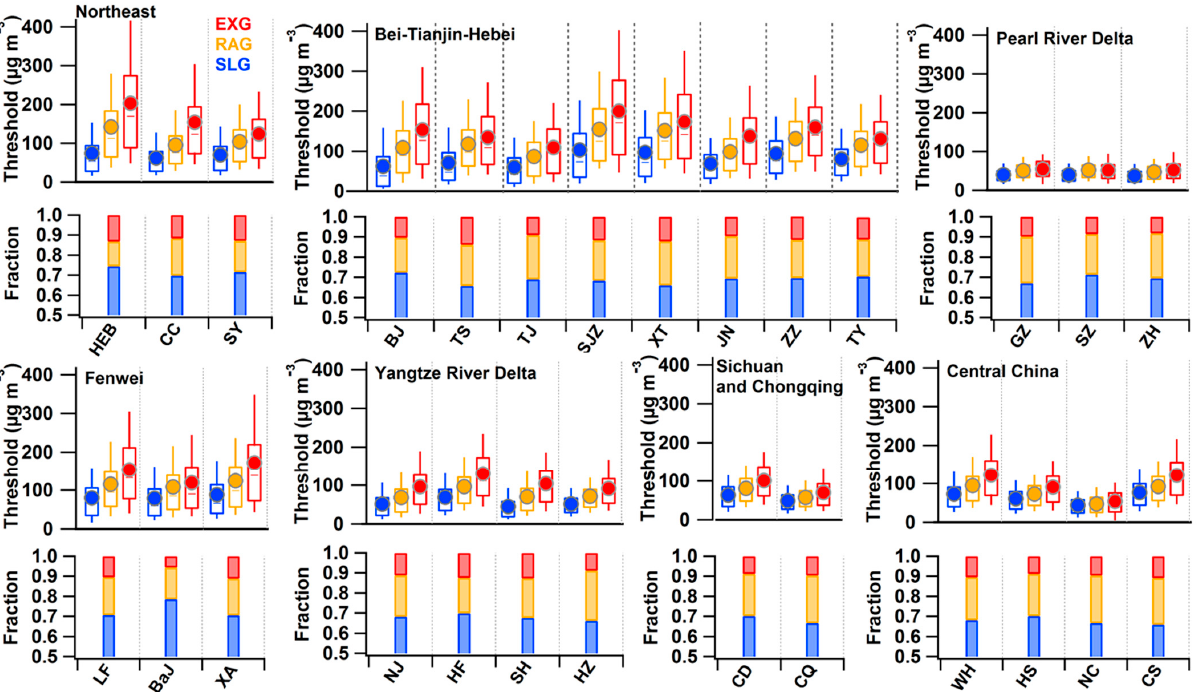
Figure 5. Thresholds for slow growth (SLG), rapid growth (RAG), and explosive growth (EXG) of each region and its representative stations, and the fraction of three growth methods. The dot is the average; the vertical line is the 10th percentile ( bottom ) and the 90th percentile ( top ); and the horizontal line is the 25th, 50th, and 75th percentile from top to bottom (the picture below is the same).